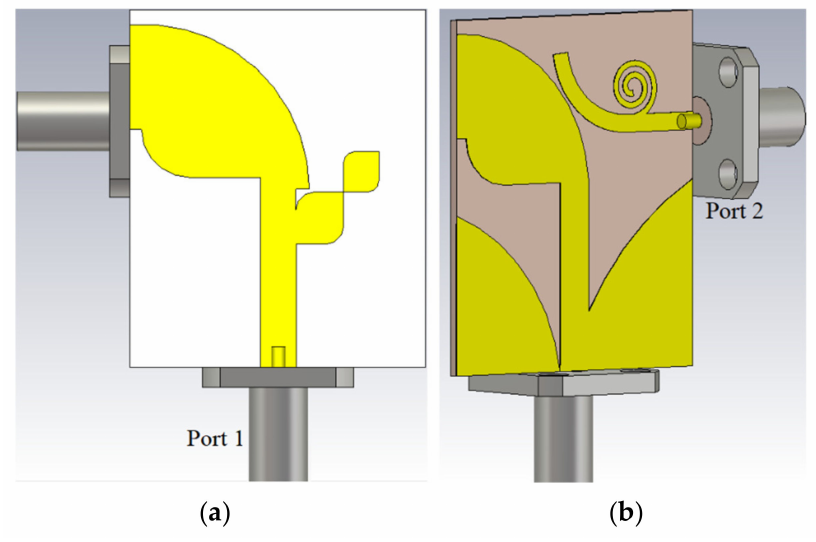
Figure 6. The proposed antenna’s ( a ) front, and ( b ) back prototype with SMA connectors. The two modes of operation, Ant 1 and Ant 2, provide vertical and horizontal polar- izations, respectively. To match the feed lines’ width W f and W t are considered. L f and L t also affect the matching. To consider the effect of the connectors, we added the SMA connectors in the simulations, as shown in Figure 6. To attain sufficient distance between the two SMA connectors, the feed lines’ length was increased to 5 mm in both x and y directions. Since two radiation modes (Ant 1 and Ant 2) are orthogonally polarized high isolation is anticipated. The simulated reflection and the transmission coefficients of the proposed antennas are shown in Figure 7. The low values of the transmission coefficients show a high-level of isolation between the two ports within the operating bandwidth (S 21 less than − 20 dB) and the antenna has a good matching (S 11 and S 22 less than − 10dB). The antenna shows matching at three frequencies for the two modes of operation Ant 1 and Ant 2, which are 3.8 GHz with a BW of almost 300 MHz, 5.2 GHz with a BW of 550 MHz, and 8.0 GHz with a BW of 300